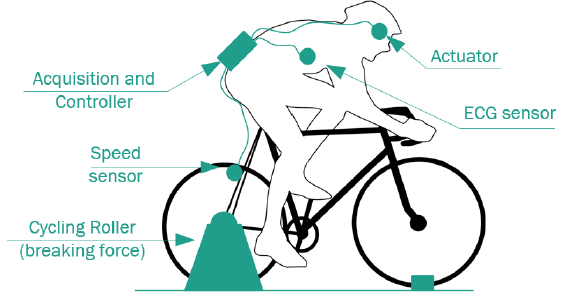
Figure 12. Testbed model